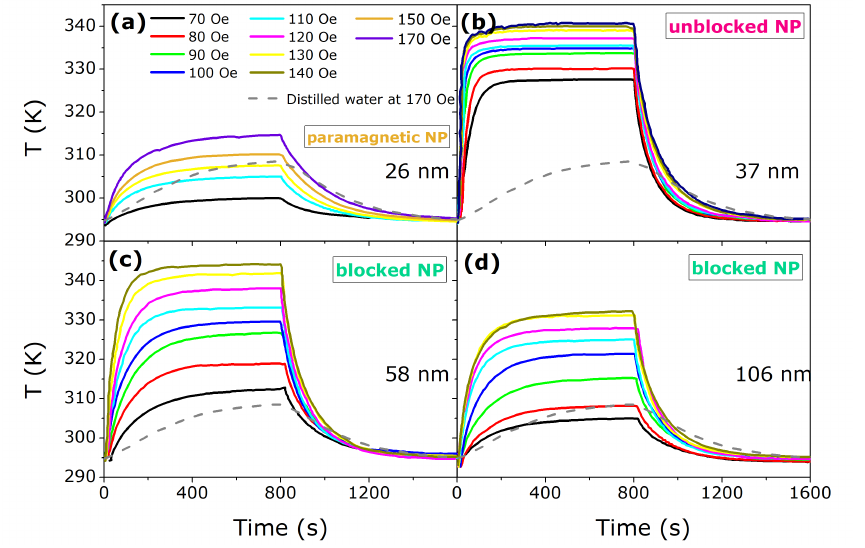
Figure 6. Heating-cooling curves for all samples prepared, for several values of AC-magnetic field. ( a ) presents the heating-cooling curves for sample 26 nm, ( b ) sample 37 nm, ( c ) 58 nm, and ( d ) 106 nm. The most efficient heating sample is the one with 37 nm of mean diameter size, because these are heated up, from room temperature, within magnetically unblocked region. See the phase diagram of Figure 5 and the text for further